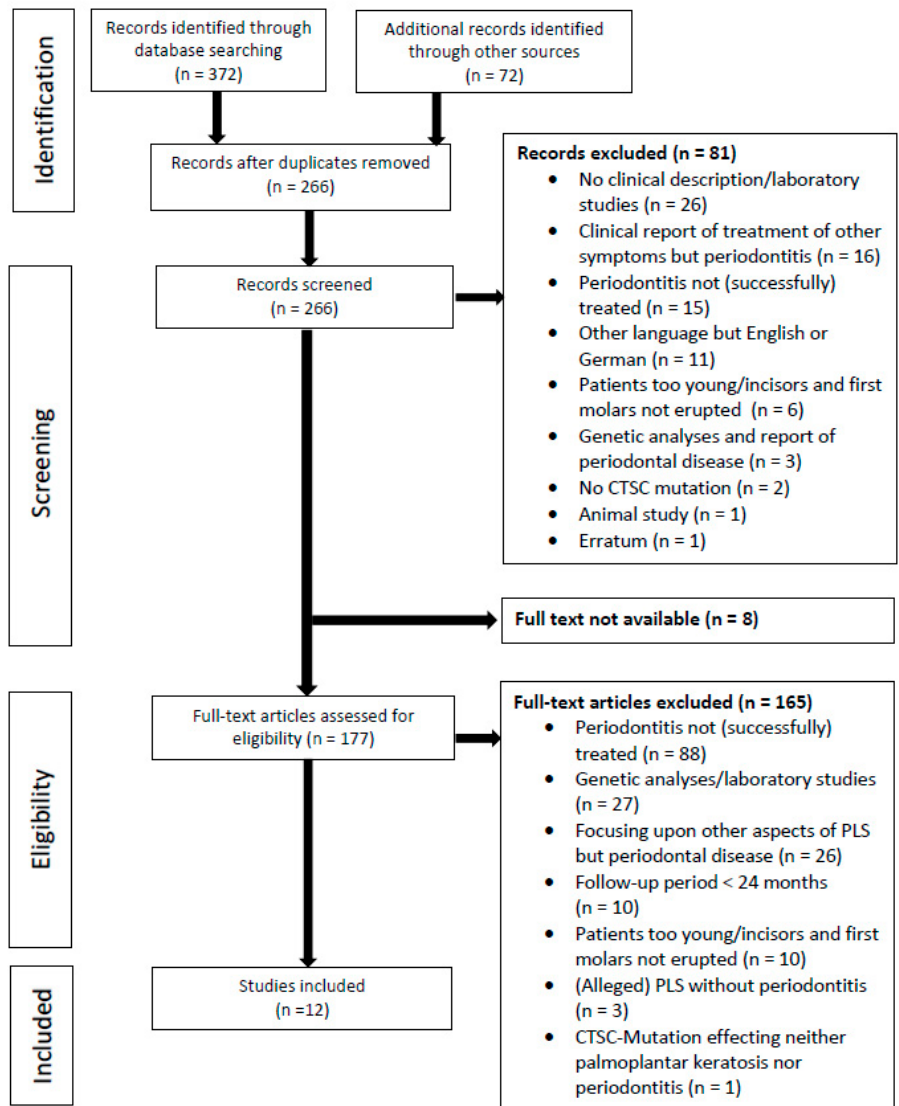
Figure 1. PRISMA flow diagram illustrating the literature search and selection process. Of the remaining 185 studies, eight were not available in full text, seven of which published between 1965 and 1997 and one abstract of an oral presentation delivered in